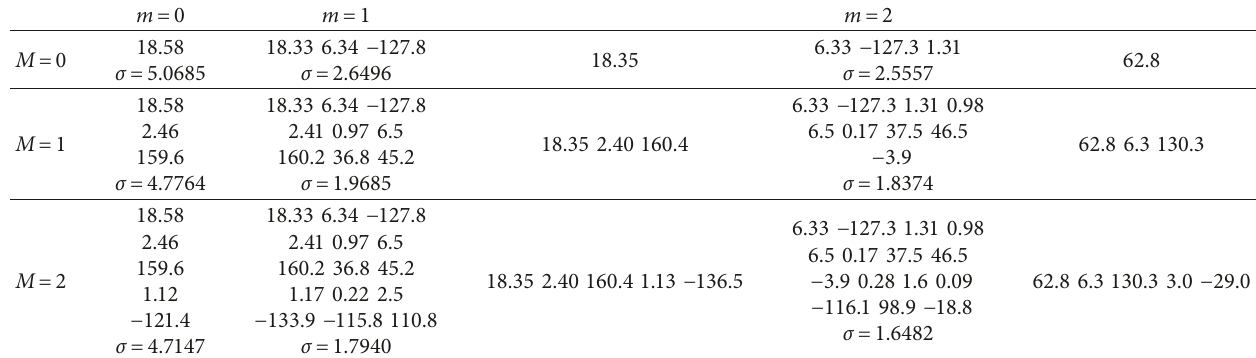
Table 3: Yearly matrices T for m � 0, 1, 2 and M � 0, 1, 2.